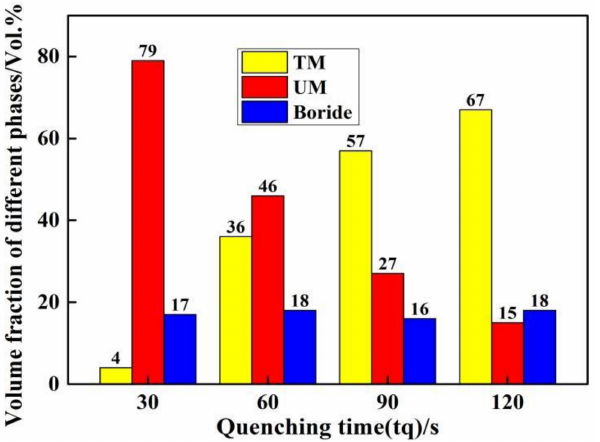
Figure 6. Quantitative results of samples under different